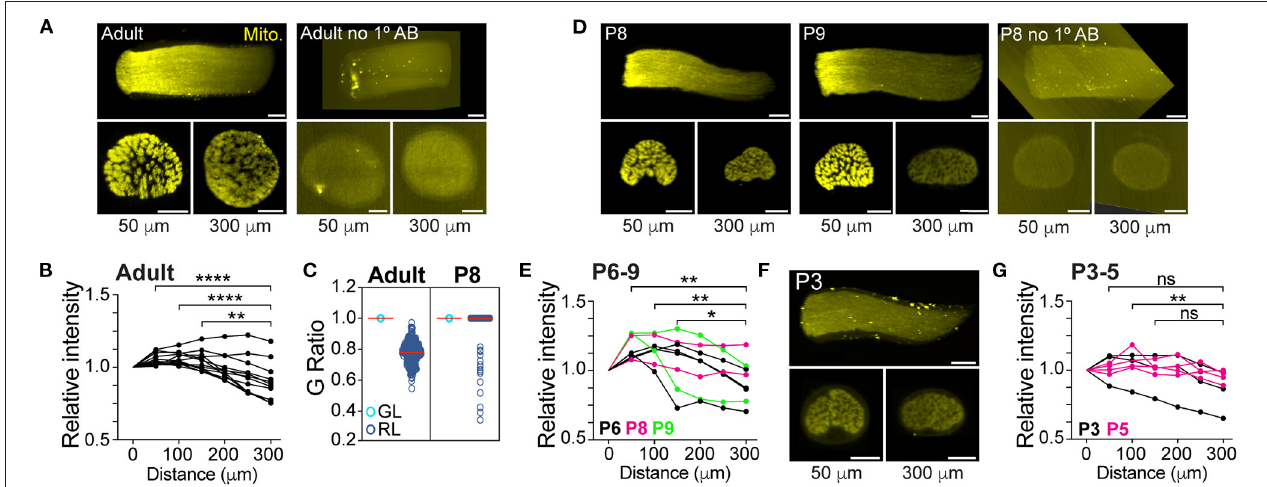
FIGURE 2 | The mitochondrial accumulation in axons of the glial lamina precedes myelination. (A) Representative 3D reconstruction of LSFM images (longitudinal view) of an adult mitoRGC optic nerve (left) and negative control (right). Optical 1.5 µ m thick cross-sectional images taken at 50 (GL) and 300 µ m (RL) from the surface of the optic nerve head are shown underneath the nerve images. (B) Quantification of the relative fluorescence along the adult mitoRGC optic nerves. ** p = 0.002, **** p < 0.0001, Friedman test and Dunn’s multiple comparisons, n = 12 optic nerves, 12 mice. (C) G Ratio of axons in the GL and RL regions in adult and P8 mice. A G ratio < 1 signifies a myelinated axon. Adult GL: n = 3042 axons, 3 mice, 3 nerves. Adult RL: n = 321 axons, 3 mice, 3 nerves. P8 GL: n = 1882 axons, 3 mice, 3 nerves. P8 RL: n = 2476 axons, 4 mice, 4 nerves. (D) Representative LSFM images of a P8 and P9 mitoRGC optic nerve and P8 negative control. (E) Quantification of the relative fluorescence along P6 to P9 mitoRGC optic nerves. ** p < 0.007, * p = 0.037, Friedman test and Dunn’s multiple comparisons, n = 8 optic nerves, 8 mice. (F) Representative LSFM images of a P3 mitoRGC optic nerve. (G) Quantification of the relative fluorescence along P3 to P5 mitoRGC optic nerves. ** p